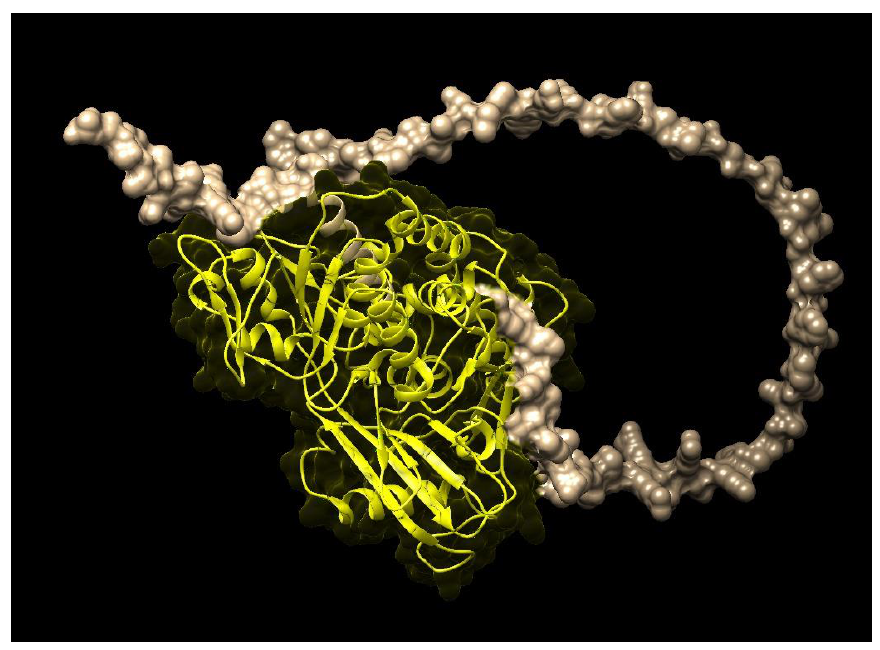
Figure 2. Three-dimensional structure of M. oleifera zeta-carotene desaturase (ZDS).